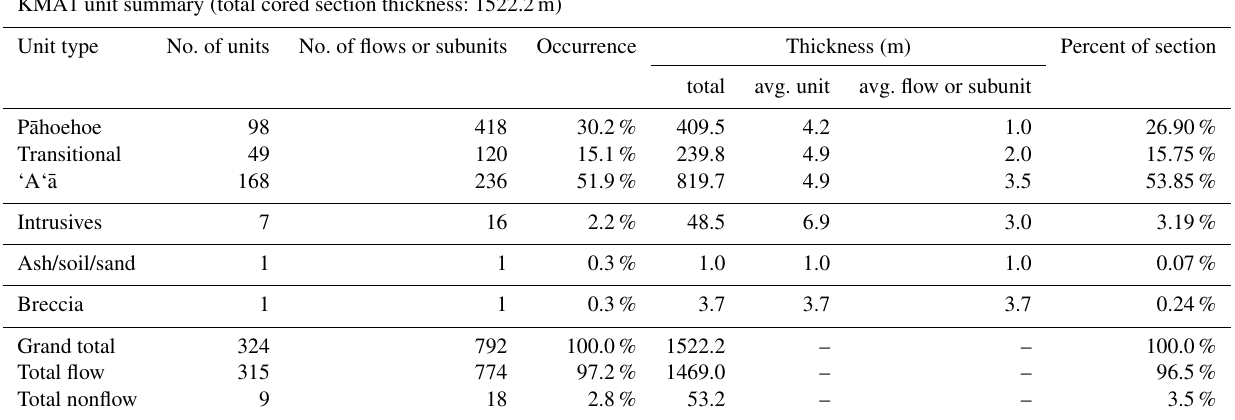
Table 2. Summary data of lithologies (facies) intersected in hole KMA1. KMA1 unit summary (total cored section thickness: 1522.2m)